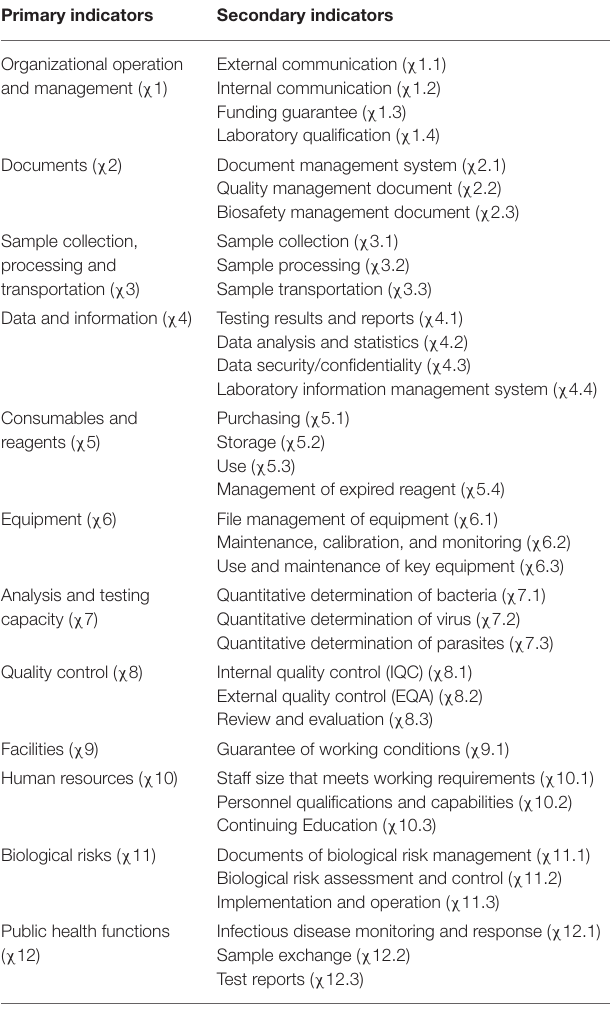
TABLE 1 | Proposed system of evaluation of comprehensive indicators for management of pathogenic microbiology laboratories. Primary